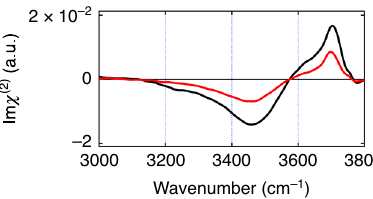
Fig. 1 Steady-state Im χ (2) spectra of the air/water interfaces. Steady- state Im χ (2) spectra of the air/neat H 2 O interface (black) and the